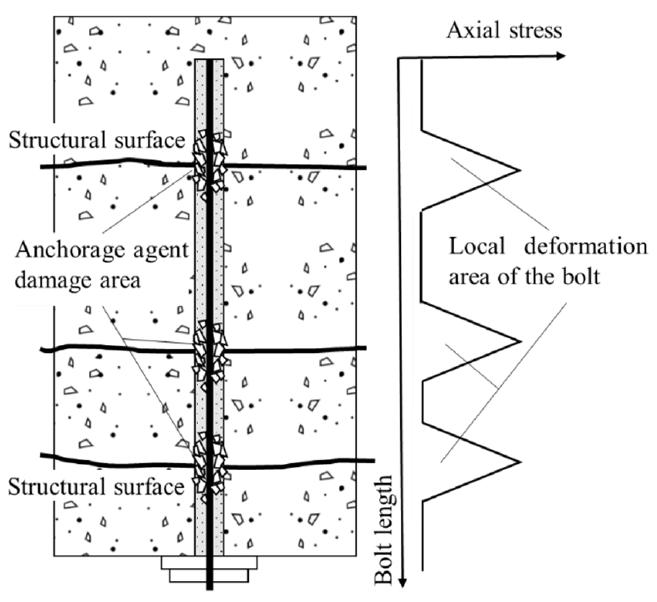
Figure 18. Schematic diagram of bolt passing through multiple structural surfaces.